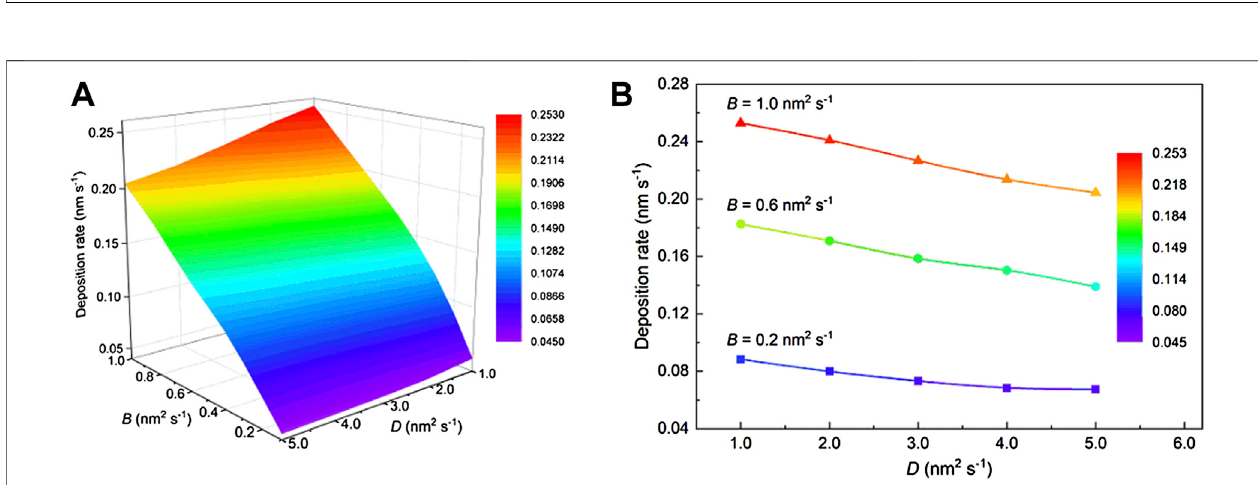
Frontiers in Materials |